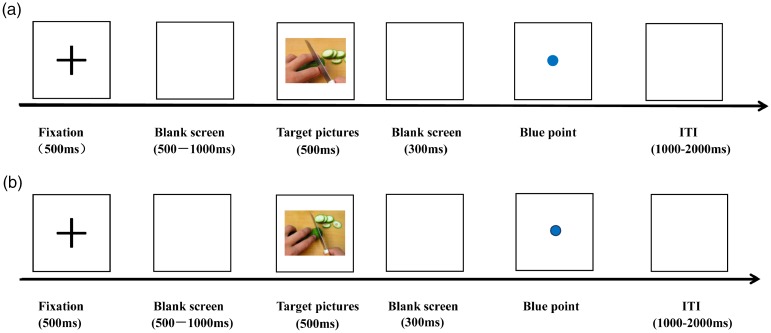
Schematic illustration of the experimental procedure (a) painful picture
trials; (b) nonpainful picture trials). ITI = intertrial interval.